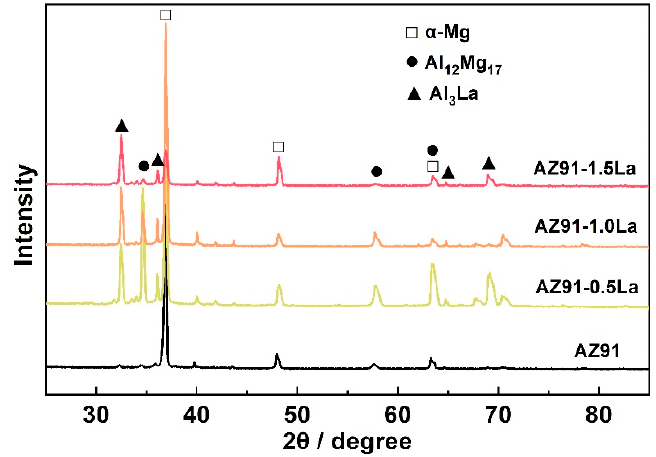
Figure 3. The SEM micrographs of ( a ) AZ91, ( b ) AZ91–0.5La, ( c ) AZ91–1.0La and ( d ) AZ91–1.5La.